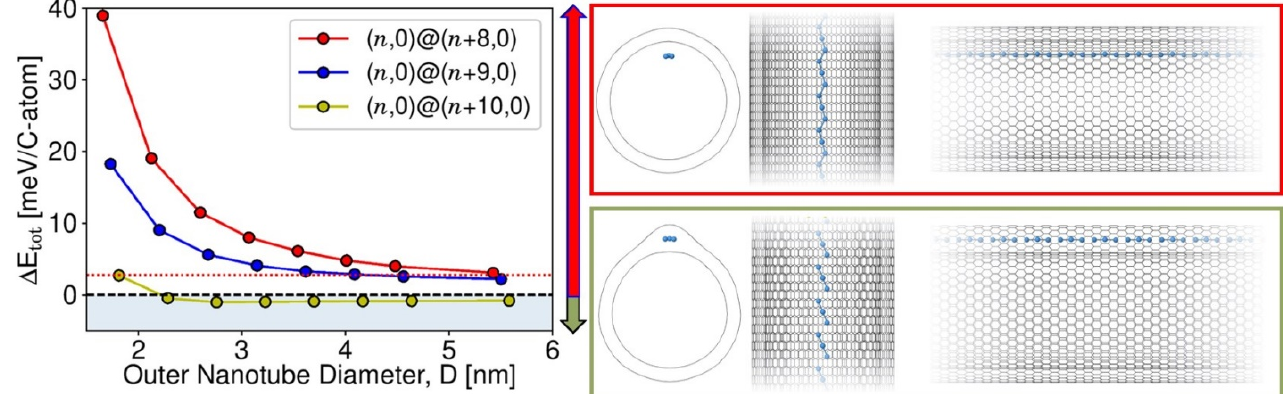
Figure 10. Left: DFT-D2 total energy difference per carbon atom (in meV/C-atom) between iodine intercalated within the graphene shells and iodine adsorbed onto the innermost shell surface, for zigzag DWCNTs. Three families of DWCNTs were considered: ( n , 0)@( n +8, 0) (red), ( n , 0)@( n +9, 0) (blue), and ( n , 0)@( n +10, 0) (green) for different diameters. The x-axis uses the diameter of the equivalent circular external shell. The shaded lower section indicates shell combinations in DWCNTs for which the intercalation of iodine between the shells was favoured. DWCNTs with Δ E tot > 0 were stabilised with the iodine chain adsorbed onto the innermost shell surface (red arrow). DWCNTs with Δ E tot < 0 were energetically favoured when the iodine chain was intercalated into the nanocavity on the buckled side (green arrow). The horizontal red dotted line represents the energy difference per carbon atom for an AA-stacked bilayer graphene (2LG) between the case where iodine was confined in the intergraphene space and the case where iodine was adsorbed on the 2LG surface. Right: Optimised cross-sections and top and side views of I@(49, 0)@(57, 0) (red frame) and I@(49, 0)@(59, 0) (green frame) DWCNTs.